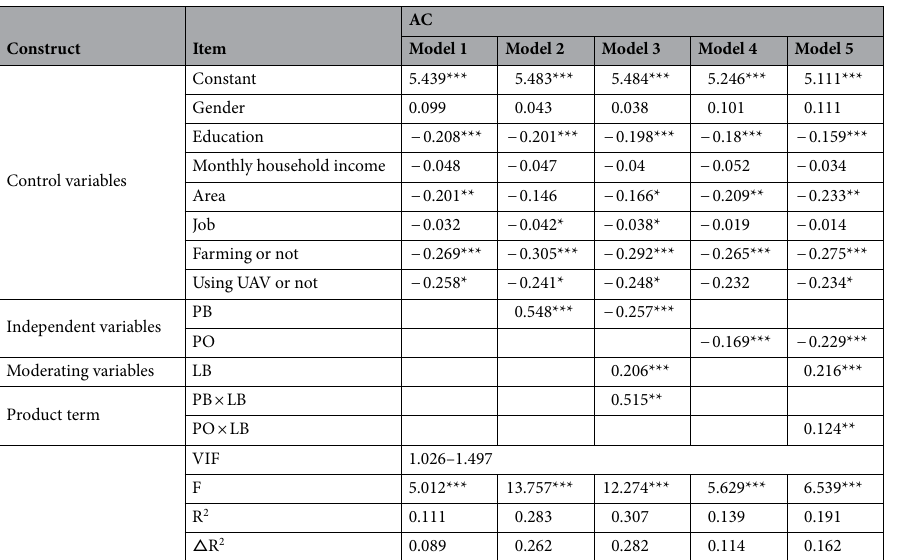
Table 7. Testing the moderating effect of lay beliefs (N = 288). Data sources: Calculation and arrangement of this paper. *** p < 0. 001, ** p < 0. 01, * p < 0. 05.